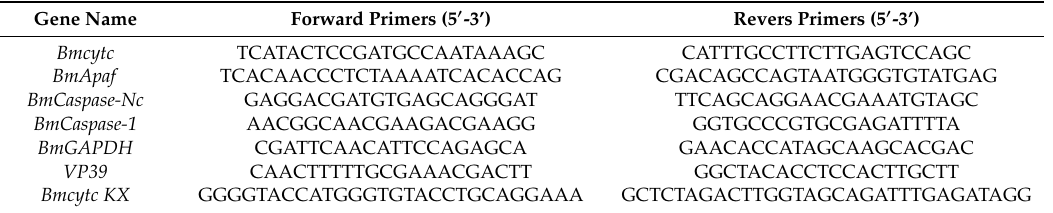
Table 1. List of primers used in this